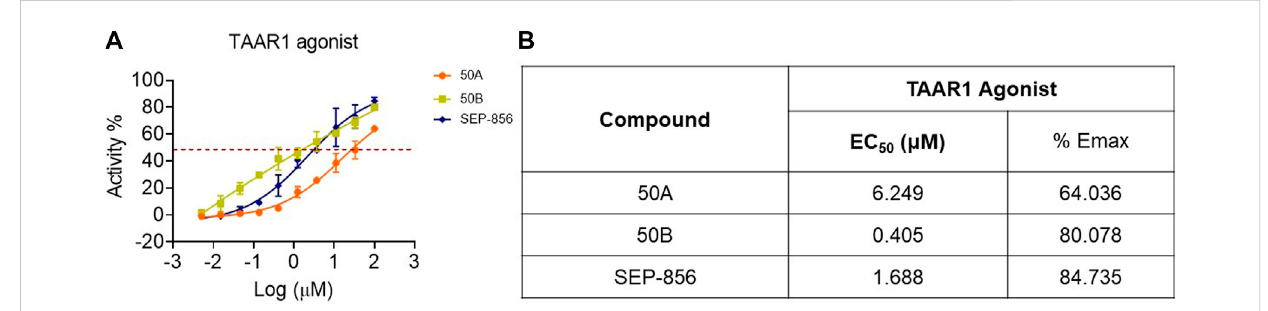
FIGURE 2 Functional effect of SEP-856, 50A, and 50B at TAAR1. (A, B) The TAAR1 functional effect assays were determined using CHO-K1 AGTRL1 Gi cells expressing human TAAR1 on the cell membrane, and cAMP modulation was determined. Every assay was repeated three times.